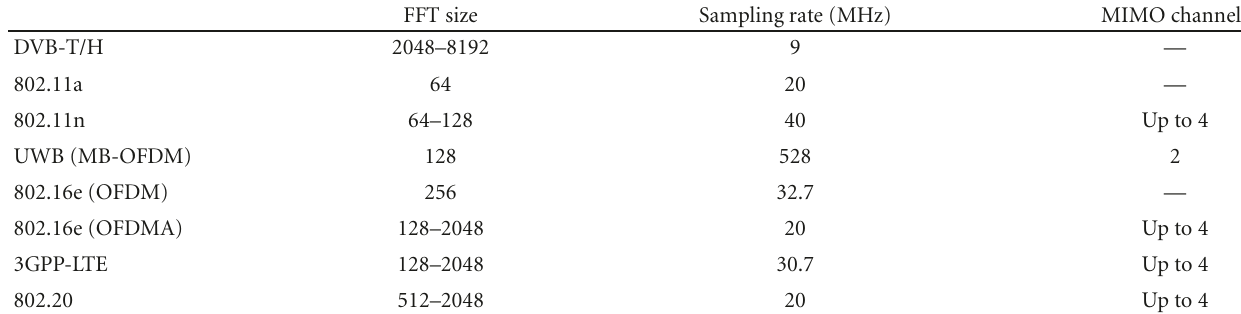
Table 1: FFT parameters in several OFDM systems..